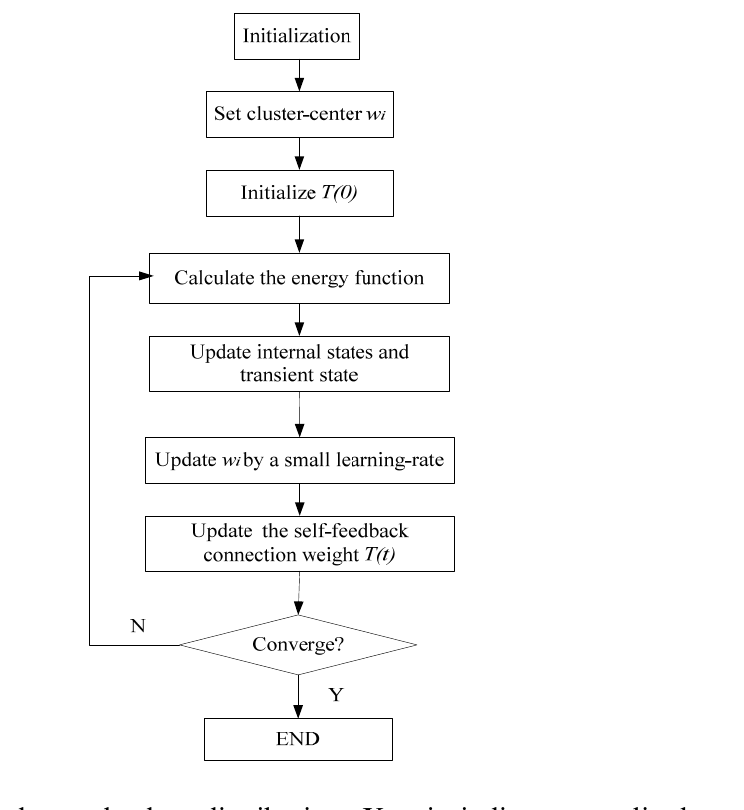
Figure 10. Experimental sample data distribution. X axis indicates amplitude entropy; Y axis indicates phase